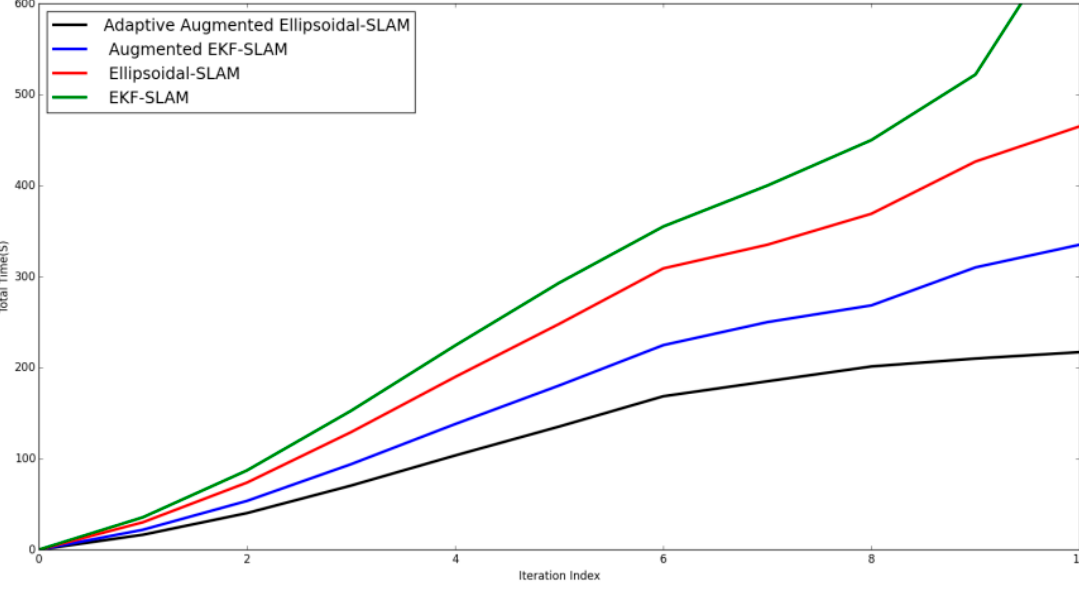
Figure 22. Steady-state time elapsed for the implemented SLAM algorithms.